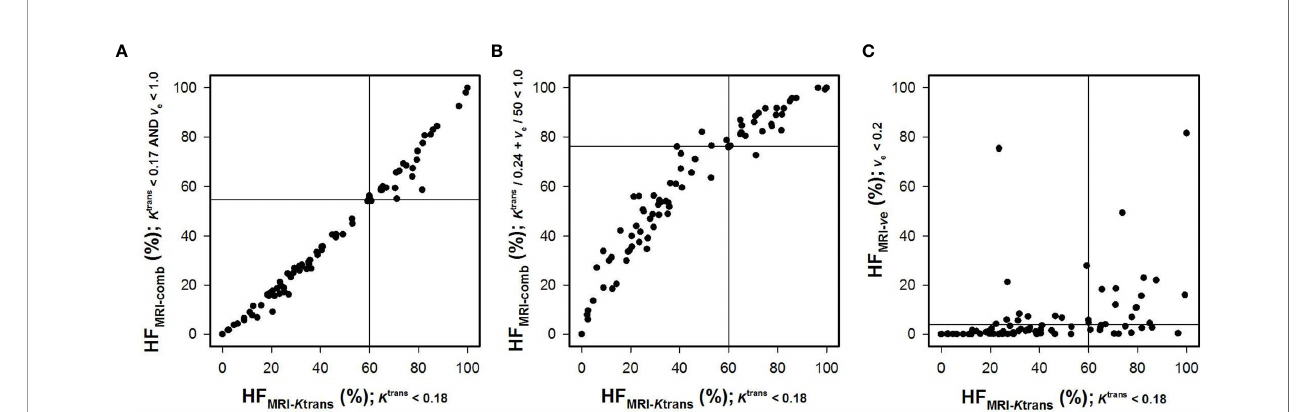
FIGURE 4 | Hypoxic fractions were calculated from K trans maps alone (HF MRI- K trans ), v e maps alone (HF MRI- v e ), or by combining K trans and v e maps (HF MRI-comb ) in locally-advanced cervical carcinoma patients. The plots show HF MRI-conp versus HF MRI- K trans (A, B) , and HF MRI- v e versus HF MRI- K trans (C) . The hypoxic fractions were de fi ned by using the thresholds (i.e. K trans 0 and v e0 ) found in Figure 3 . Points represent individual tumors and solid horizontal and vertical lines show the border between patients with high and low HF MRI